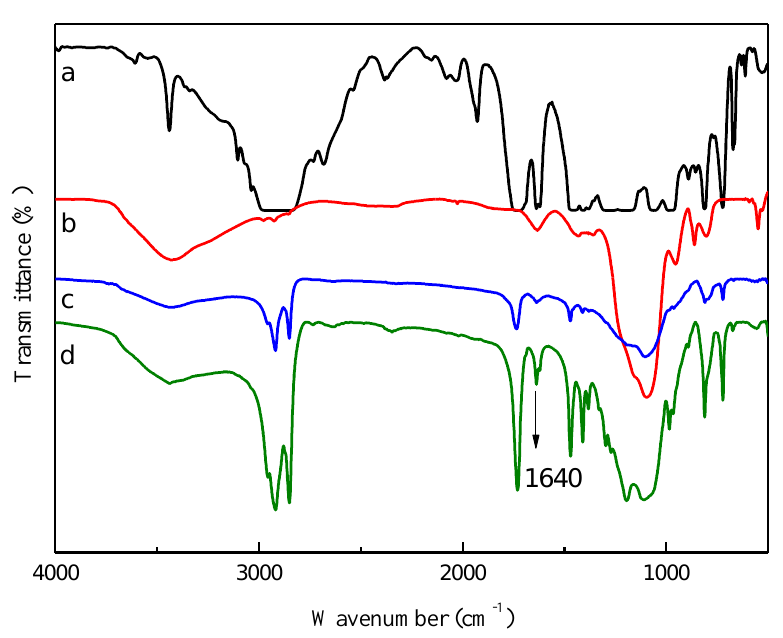
Figure 1. FT-IR spectra of ( a ) PM18; ( b ) SiO 2 ; ( c ) PM18/SiO 2 ; ( d ) PM18-g-NSiO 2 .